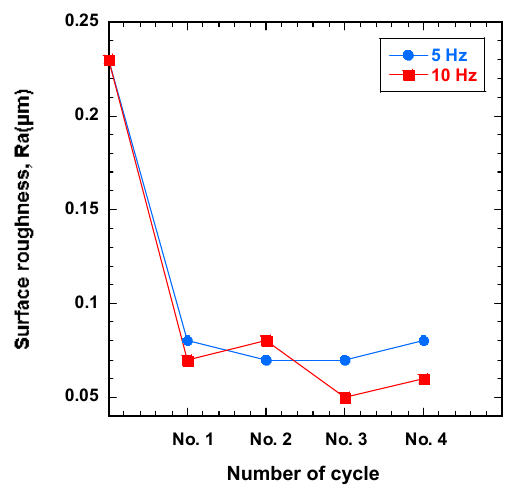
Figure 7. Surface roughness (Ra) as a function of the number of finishing cycle for different magnetic field vibration frequencies with industrial magnetic abrasive tools.